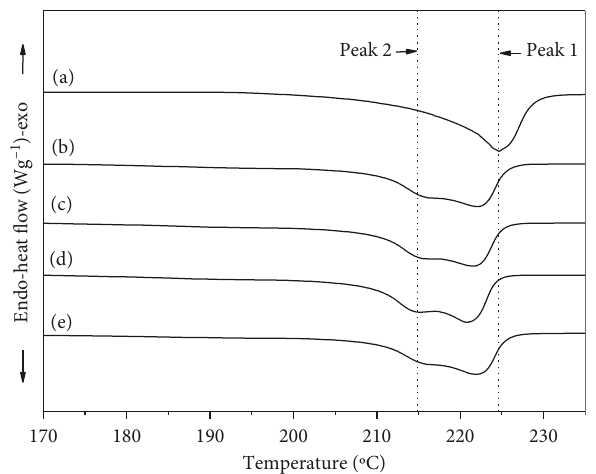
Figure 4: Endothermic thermograms of the nylon 6 (a) and the nanocomposites at the concentrations of 0.01 (b), 0.05 (c), 0.10 (d), and 0.50 (e)